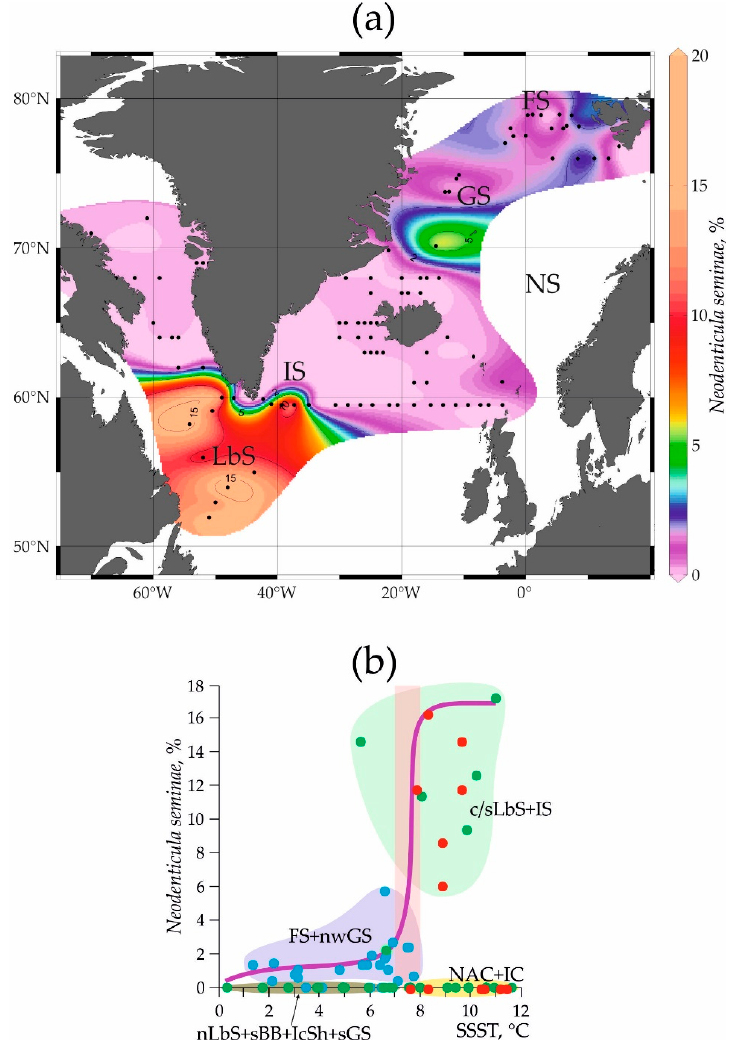
Figure 2. (a) is the distribution of N. seminae in the surface sediment samples of the Nordic and Labrador Seas, data from [9,12] and this study (Table A1). Black dots mark diatom samples. (b) is a plot of N. seminae percentages in the surface sediments, data from [9,12] and this study (Table A1), versus SSST (Summer Sea Surface Temperature). SSST for the period of 2007–2017 is extracted from the World Ocean Atlas 2018 [24]. Purple line approximates distribution of N. seminae greatest percentages. Transparent red vertical bar marks a rapid change of N. seminae abundances. Colored fields mark geographical areas: LbS is Labrador Sea, c/sLbS is central/southern Labrador Sea, nLbS is northern Labrador Sea, IS is Irminger Sea, GS is Greenland Sea, nwGs is northwestern Greenland Sea, sGs is southern Greenland Sea, sBB is southern Baffin Bay, NS is Norwegian Sea, FS is Fram Strait, IcSh is Iceland Shelf, NAC is North Atlantic Current, IC is Irminger Current. Blue, green, and red dots mark data from [9,12], and this study (Table A1), respectively. The map is created by Ocean Data View software